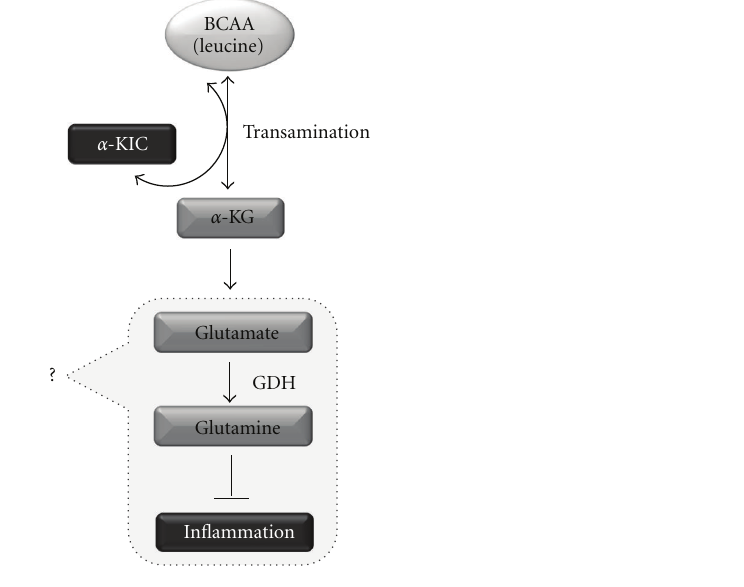
Figure 2: Possible role of glutamine as an intermediary of BCAA action on skeletal muscle inflammation. BCAA could modulate inflammatory response through glutamine synthesis. Such reaction occurs through BCAA transamination and generation of glutamate from α -KG. Glutamate is then converted to glutamine by glutamine synthetase. α -KG: alpha-ketoglutarate; α -KIC, α -ketoisocaproate; BCAA: branched-chain amino acids; GDH: glutamate